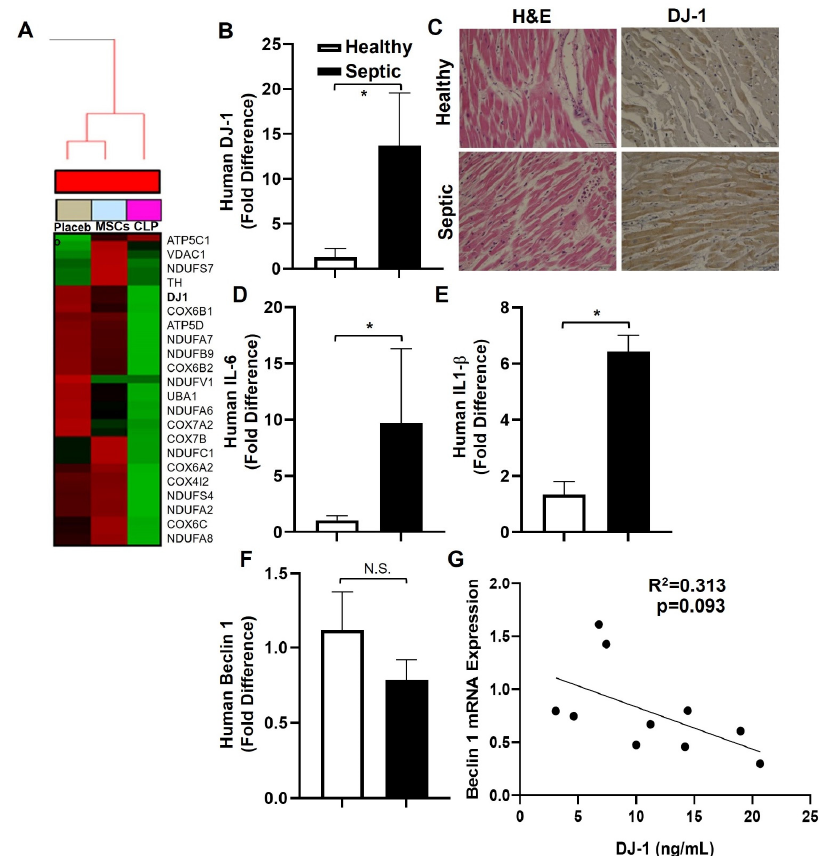
Figure 1. Identification of DJ-1/PARK7 through Bioinformatic Analyses and Expression in Human Septic Patients. ( A ) Gene expression profile of Kegg Parkinson’s disease gene-set in the heart after